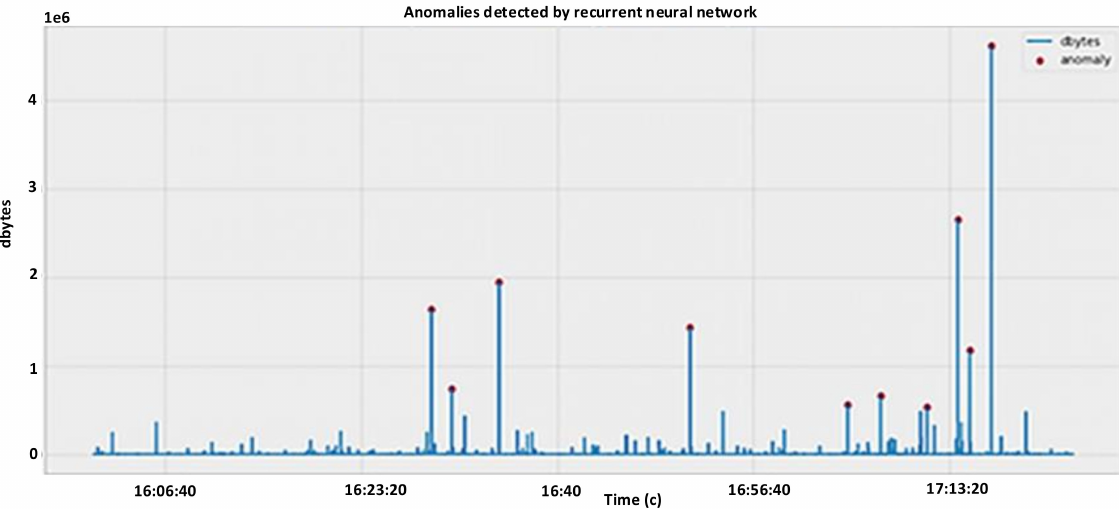
Figure 34. Approximation up to 5000 packets.